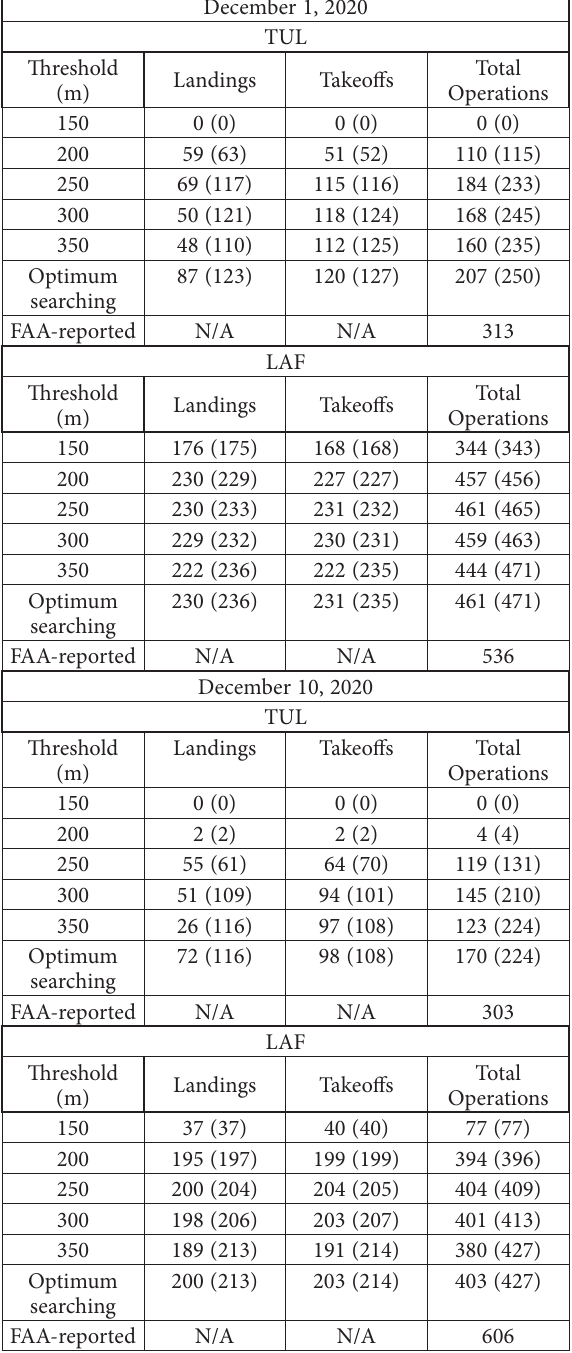
Table 2. The same threshold altitude analysis for a one-day range (December 1, 2020, and December 10, 2020) reveals that the “optimum” threshold altitude is not constant, especially at TUL. The maximum takeoffs occurred by setting the altitude threshold at 300 m on first test day, but 350 m on the second test day. In the “optimum searching” row, we allowed the algorithm to search for altitudes that resulted in maximum landings and takeoffs by iterating the post- processing algorithm in the 150 to 350 m altitude threshold range with 5 m intervals. The numbers reported in parenthesis use a 2.0 NM boundary box, whereas the rest of the numbers reported are for a 0.5 NM boundary box